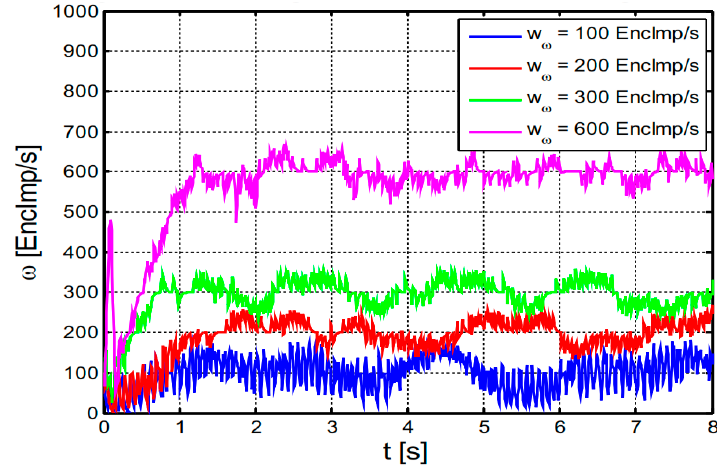
Figure 9. Different step responses of the closed speed controller.